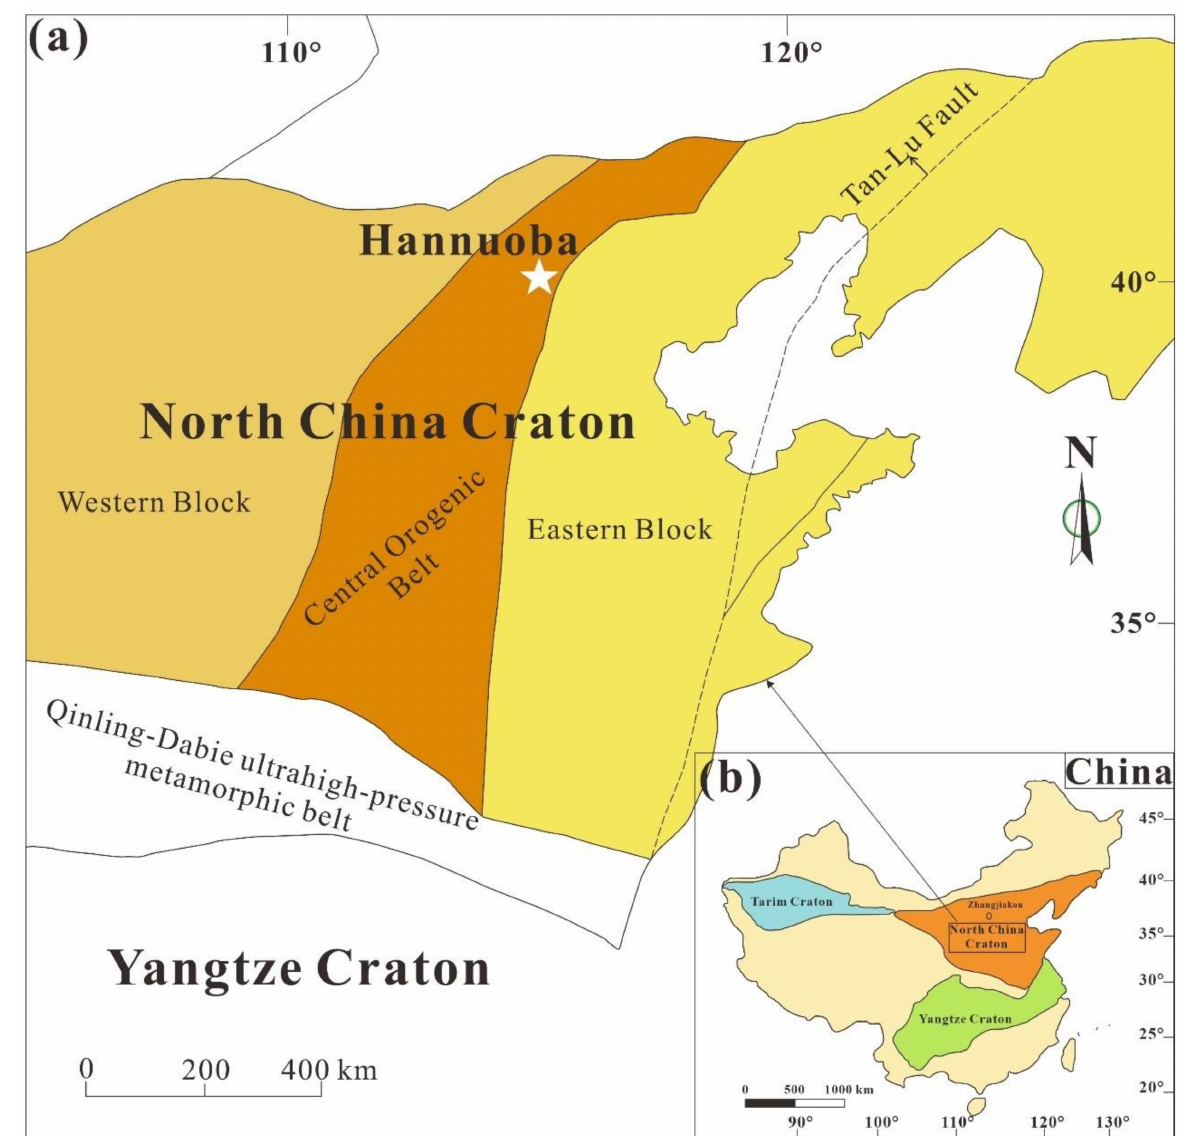
Figure 1. ( a ) Geographical map showing the distribution of the cratons in China (modified after Zhou et al. [24]; ( b ) Tectonic subdivisions of North China Craton and the geographic location of Hannuoba. Note: White star represents Hannuoba Region (modified after Gao et al.